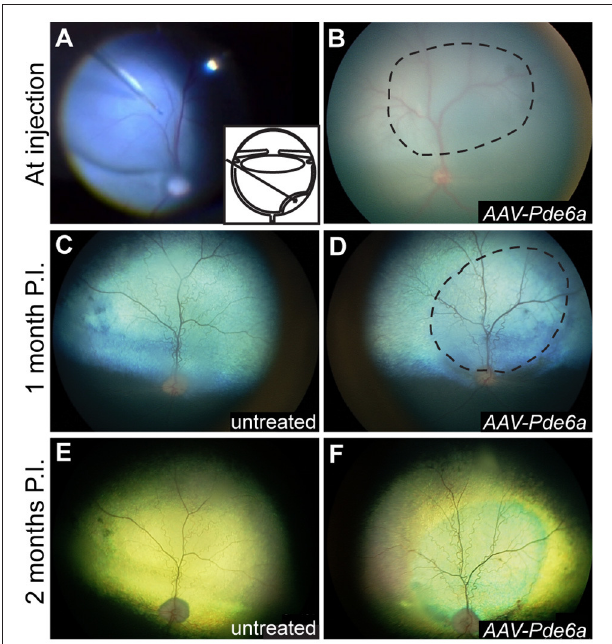
FIGURE 3 | Fundus photography. Subretinal injections of vectors were performed at 29–44 days of age; a representative intraoperative color